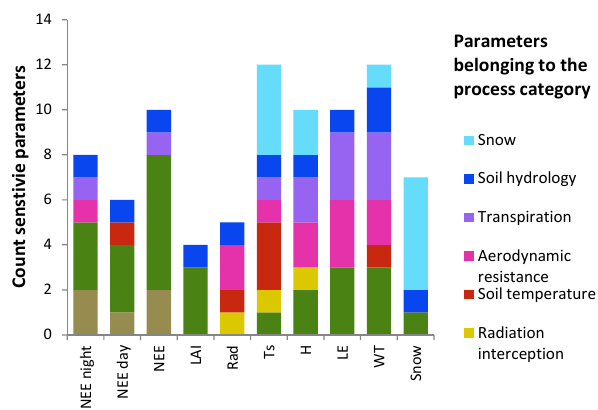
Figure 4. Average overlap of accepted ranges per parameter within each process and between processes, i.e. how unambiguously the parameters could be constrained. Negative values indicate the dis- tance between accepted ranges when ranges did not overlap at